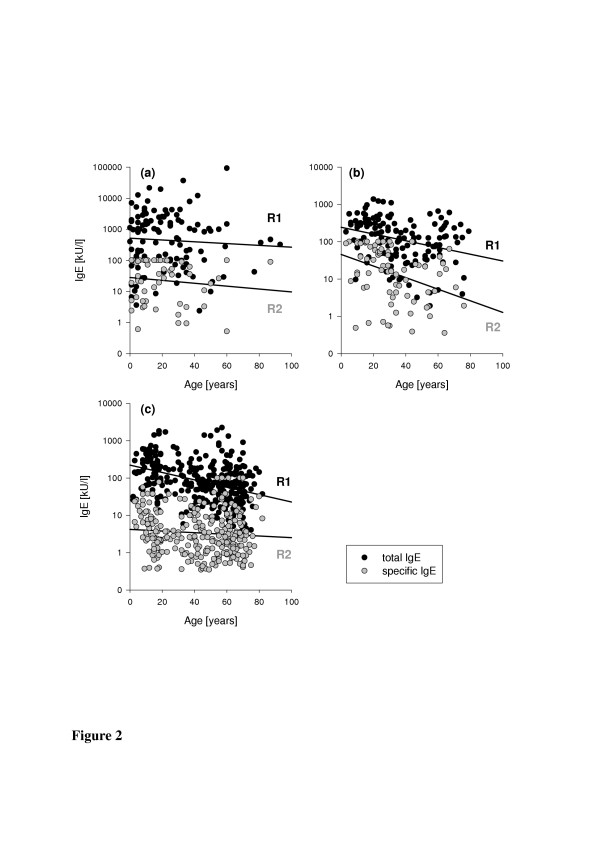
Correlation between age and IgE. Multiple scatter plots of donor age versus total (●) and specific (○) serum IgE. (a) patients with AD, (b) patients with allergic asthma or rhinitis; (c) patients with insect allergy. R1, line for total IgE and R2 for specific IgE derived from simple linear regression.